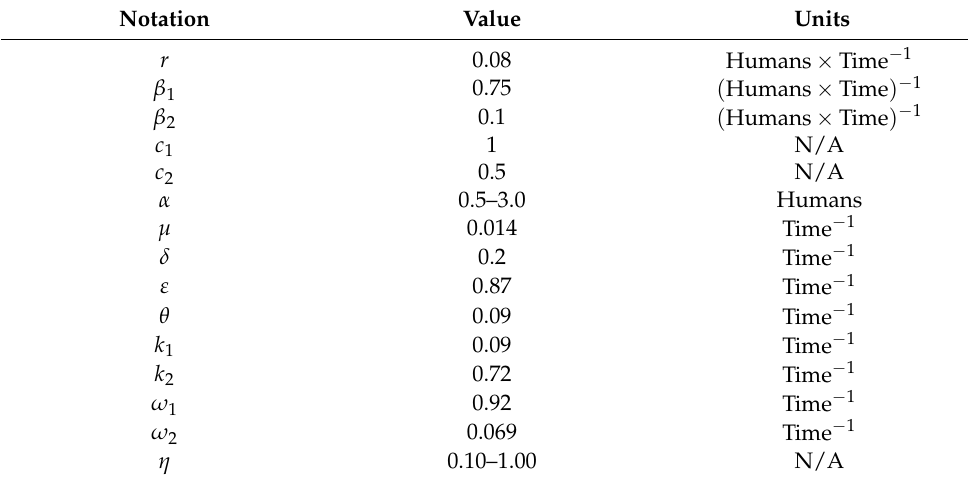
Table 2. Values of the parameter occurring in the model.